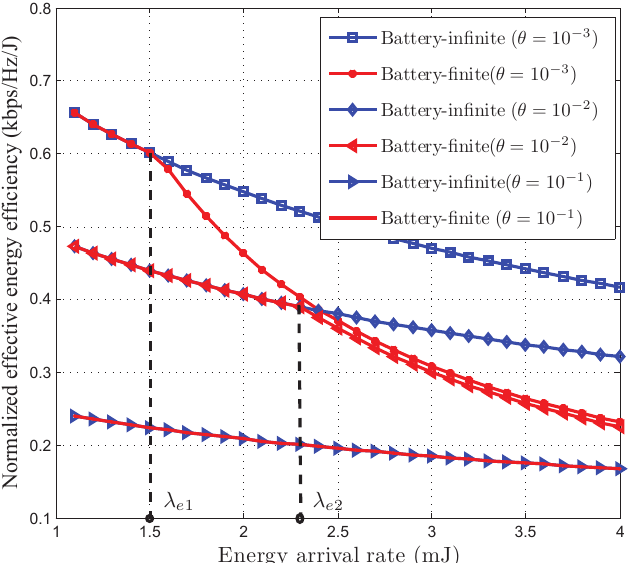
Figure 6. The normalized effective energy efficiency of our developed QoS-driven power control policies versus energy arrival rate for battery-infinite/finite energy harvesting based wireless sensor